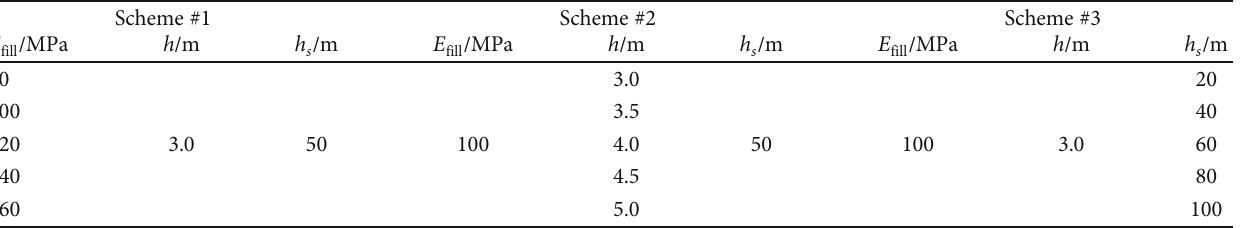
Table 2: The calculation